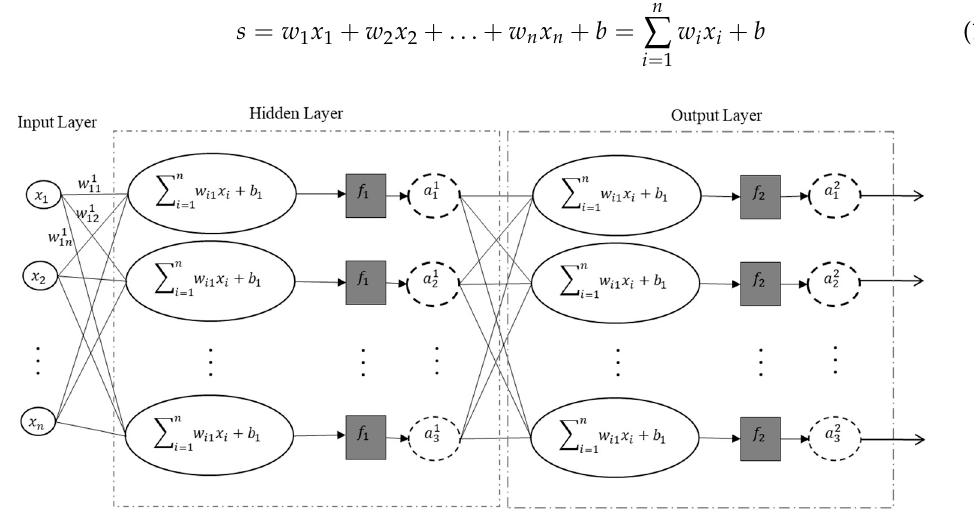
Figure 2. Architecture of artificial neural network with one hidden layer. The superscripts represent the layer number. The first and second subscripts, respectively, represent the input and neuron number that are associated together in each layer.